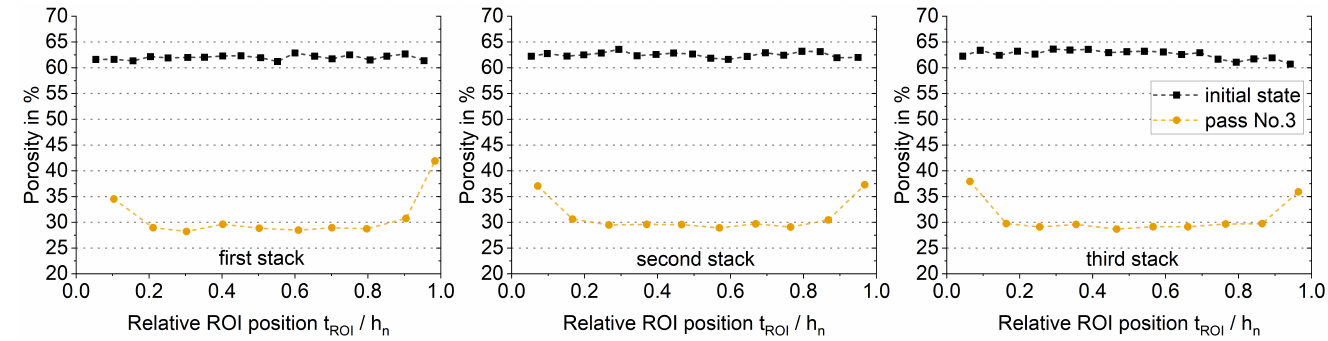
Figure A5. Series II: 5-0.50-3 ( l d / h m ≈ 2.25 − 2.9): Porosity change over relative sample depth (0=upper surface; 0.5= mid-section of sample; 1=lower surface) due to rolling for first, second and third stack.